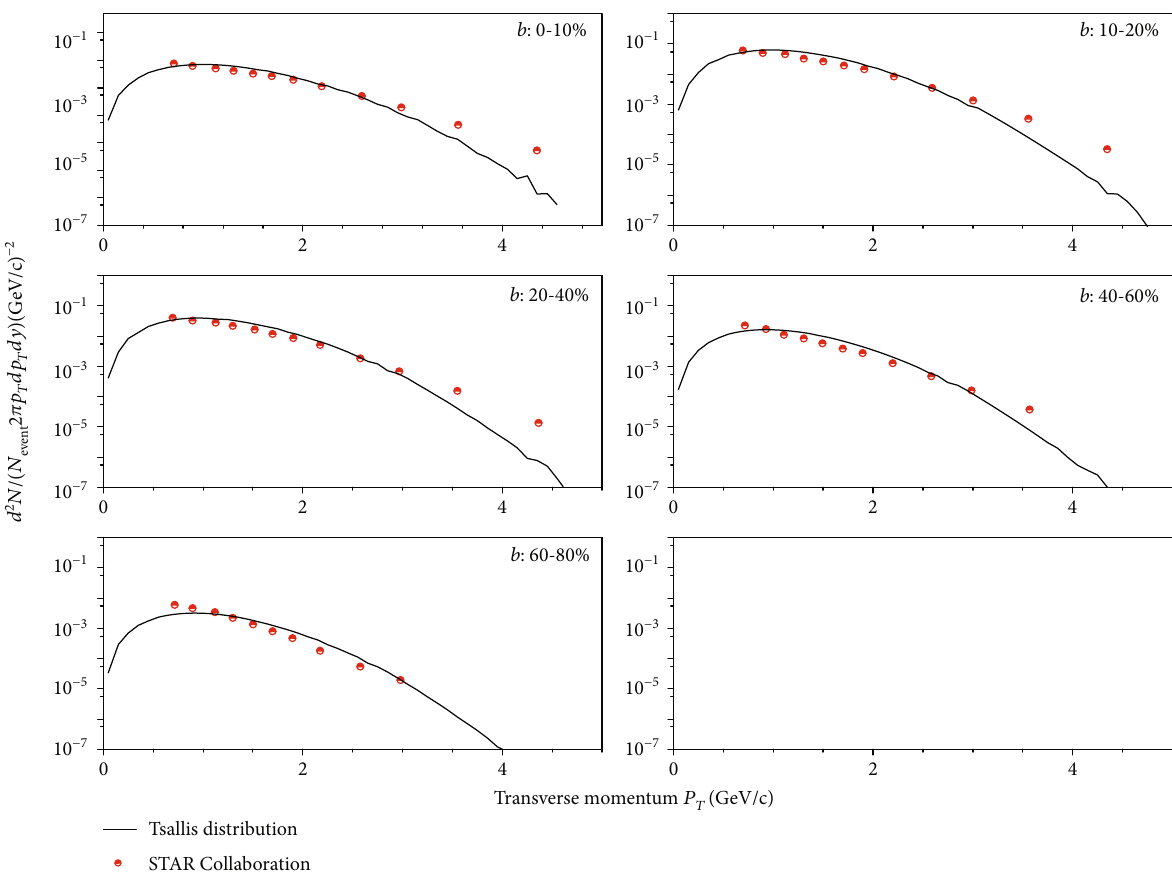
ffiffiffiffiffiffiffi p = 14 : 5 GeV for 0-10%, 10-20%, 20-40%, 40-60%, and 60- s NN